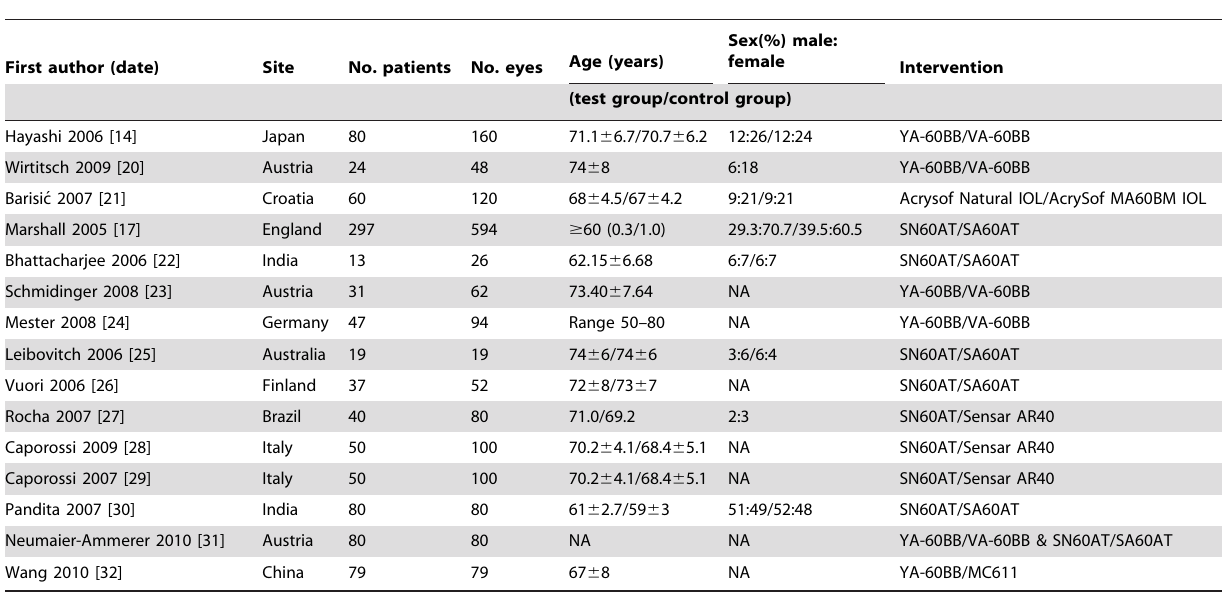
Table 1. Characteristics of RCTS (n =15) included in the